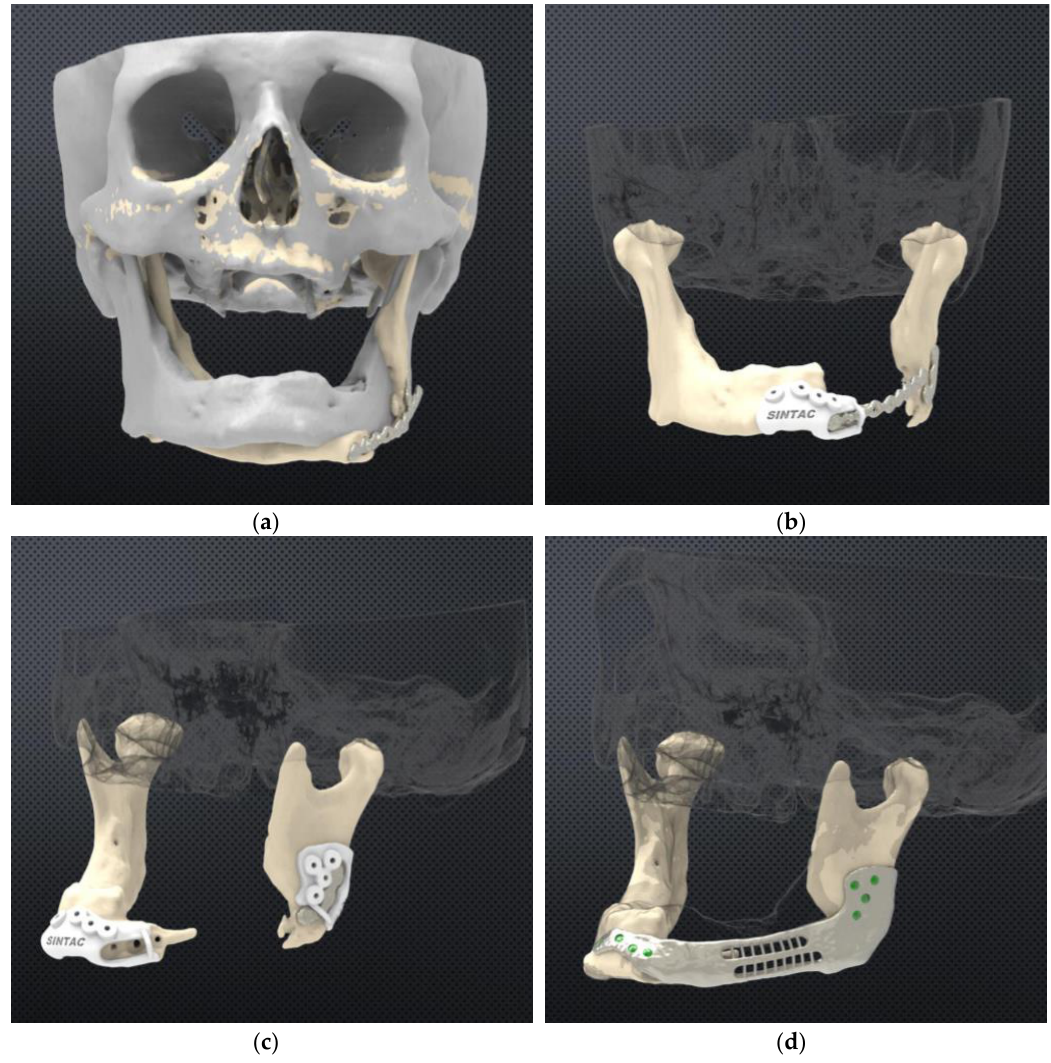
Figure 2. Computer-aided design of plate and drilling guides. ( a ) Superimposition of the native mandible (grey) and postresection (yellow) CT-scan data, showing mandibular displacement for plate rupture. ( b ) After mandibular segment 3d-repositioning; the design of the symphysis cutting and drilling guide, fixed on a fractured plate. ( c ) Design of ramus cutting and drilling guide. ( d ) Design of customised bridging mandibular prosthesis (CBMP).